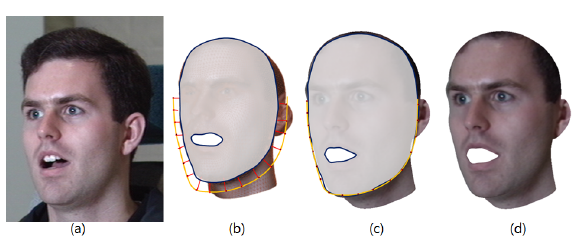
Figure 5. Proposed fitting process.